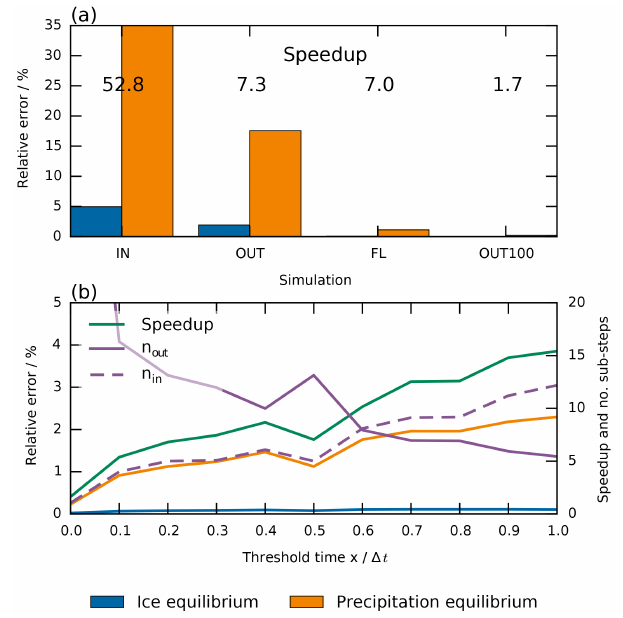
Figure 6. Relative errors | (φ SIM − φ T 6 )/φ T 6 | and speedup factor t T 6 /t SIM within the cloud microphysics scheme for the simulations SIM shown in Figs. 4 and 5 together with a new simulation OUT100 that achieves α < 1 throughout the column only by using the outer loop. (a) Blue and yellow bars show the relative error of the ice wa- ter path and surface precipitation at equilibrium. (b) Relative errors as in (a) (orange and blue lines). Purple lines show the number of outer (solid; right axis) and inner (dashed; right axis) iterations. The green line shows the speedup (right